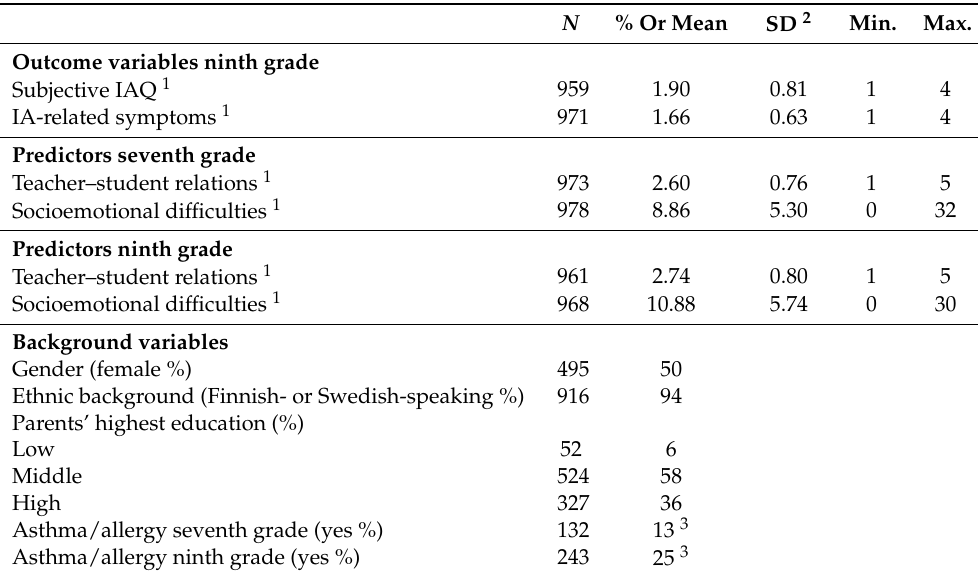
Table 1. Descriptors of all used variables ( N =